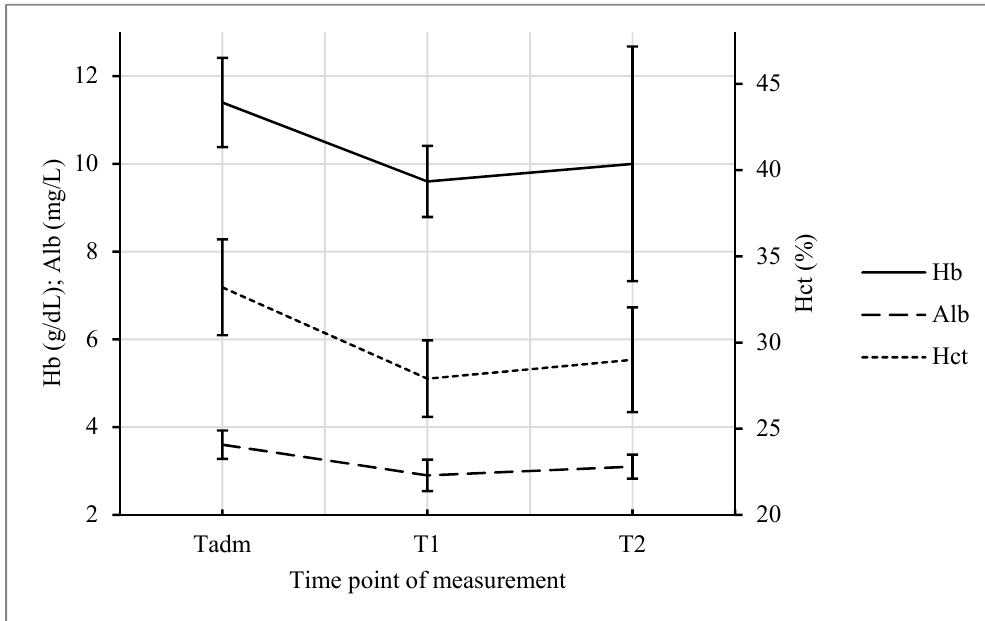
Figure 1. Hemoglobin (Hb), hematocrit (Hct), and albumin (Alb) before admission (T adm ), 2 h (T1), and 24 h (T2) after the intervention, respectively. Data presented as mean values (SD) (T adm to T1 all p < 0.001).